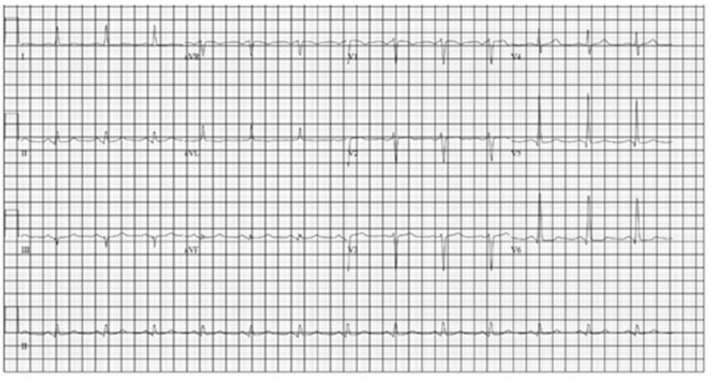
First EKG (11/12/18).